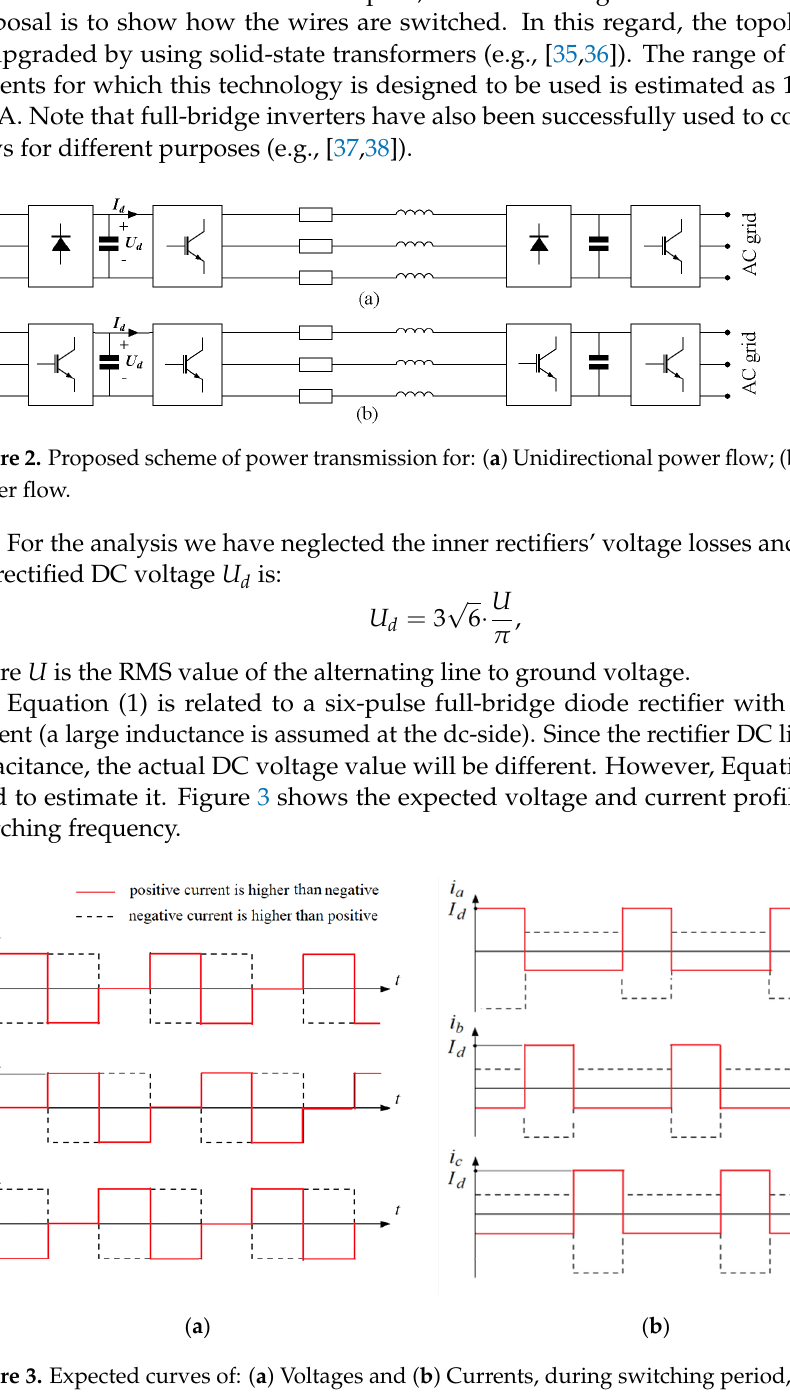
Figure 1. Operating state of the conductors according to the proposed method; 𝑇 represents the switching period.